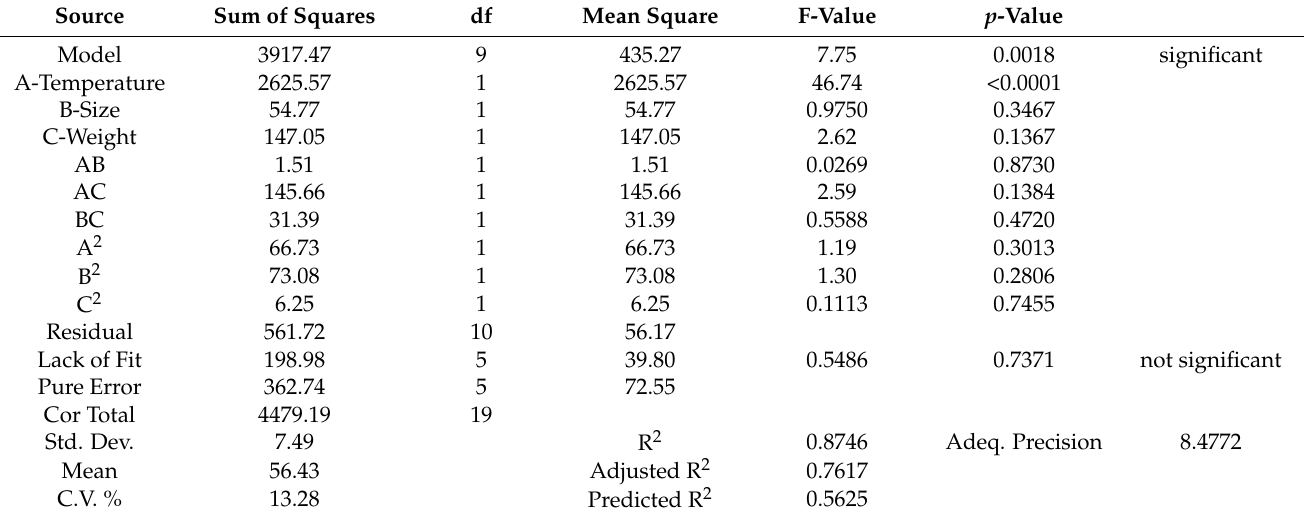
Table 3. The experimental results from the CCD quadratic model for dye decolourisation of STDW.